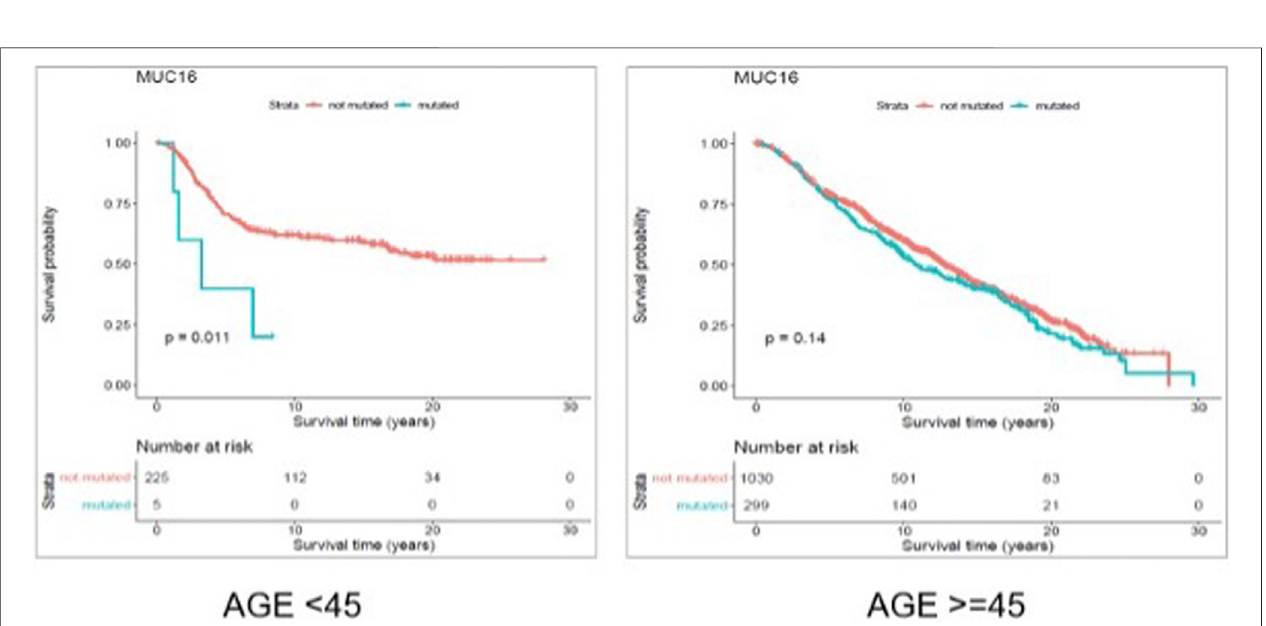
FIGURE 6 | Results from disease free survival (DFS) analysis comparing the survival time of breast cancer patients possessing a mutated or un-mutated Muc16 gene. The difference between the two groups (with and without mutations in Muc16 gene) is signi fi cant among young (under 45 years of age) individuals ( p -value (cid:1) 0.011), while not signi fi cant in older patients ( p -value (cid:1)